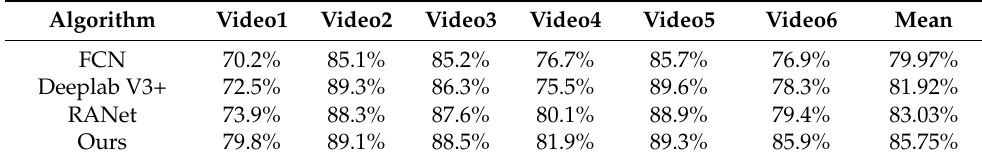
Table 4. F 1 − score of testing examples in Dataset 3.